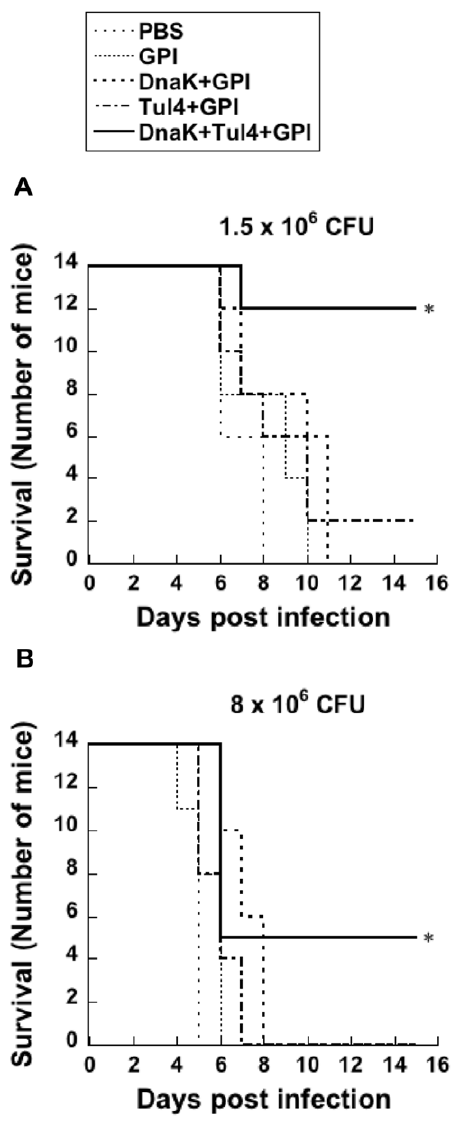
Figure 6. Immune reactivity to DnaK and Tul4 confers protection against a lethal respiratory challenge with FT LVS. Mice were immunized on day 0, 14 and 28 with DnaK + GPI, Tul4 + GPI or DnaK + Tul4 + GPI. Control groups of mice received PBS or GPI. Two weeks after the last immunization, mice were challenged with either (A) 1.5 6 10 6 CFU or (B) 8 6 10 6 CFU of FT LVS via the i.n. route and survival was monitored for 30 days. The results show pooled data of two independent experiments (a total of 14 mice per group). Significant differences were seen at P , 0.001 (*) compared to mice immunized with GPI only.